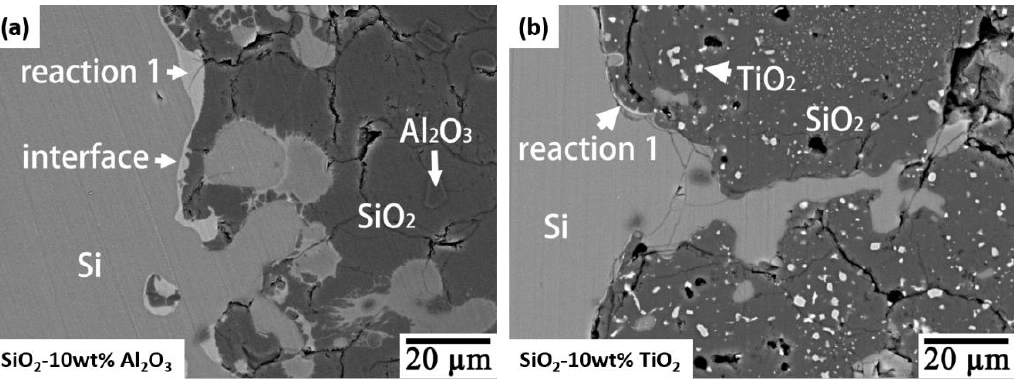
Figure 8. BEIs/SEM images of ( a ) Si/SiO 2 – 10 wt.% Al 2 O 3 and ( b ) Si/SiO 2 – 10 wt.% TiO 2 interfaces.